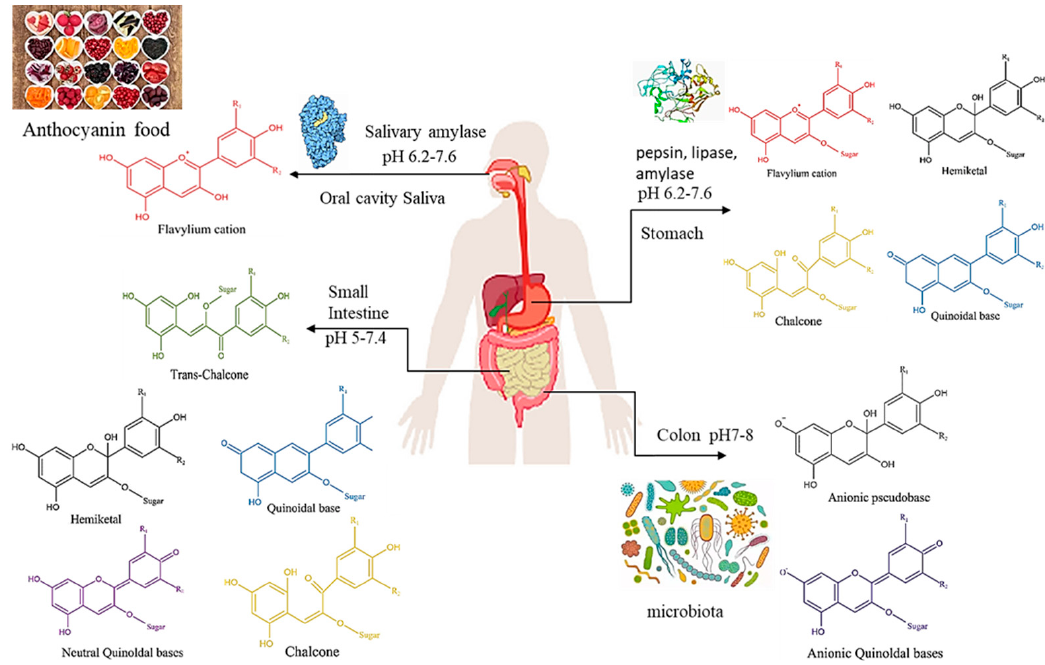
Figure 2. Schematic representation of anthocyanin degradation and absorption in different regions of the human gastrointestinal tract [7].